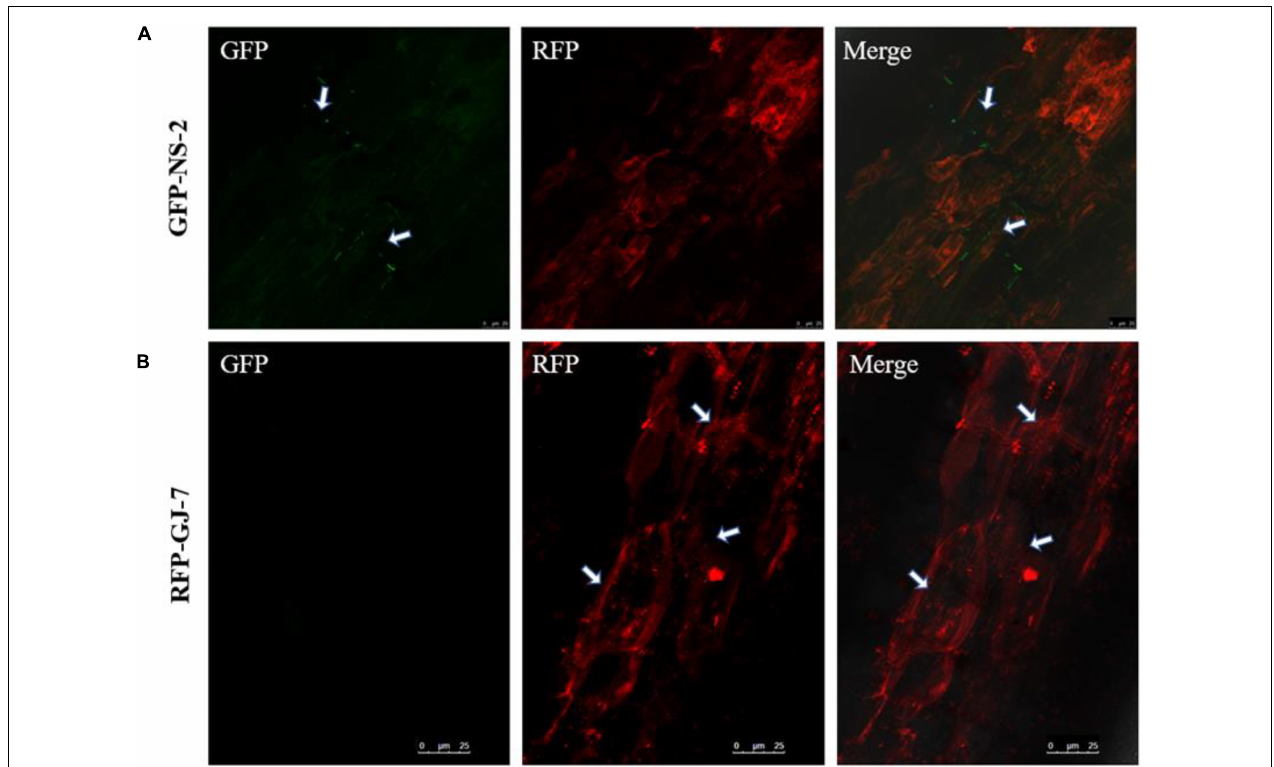
FIGURE 7 | Colonization observation of the strains NS-2 and GJ-7 on Panax notoginseng roots. (A) Images of GFP-tagged strain NS-2-treated roots in the dark field (GFP), the dark field (RFP), and the superposition field (merged). (B) Images of RFP-tagged strain GJ-7-treated roots in the dark field (GFP), the dark field (RFP), and the superposition field